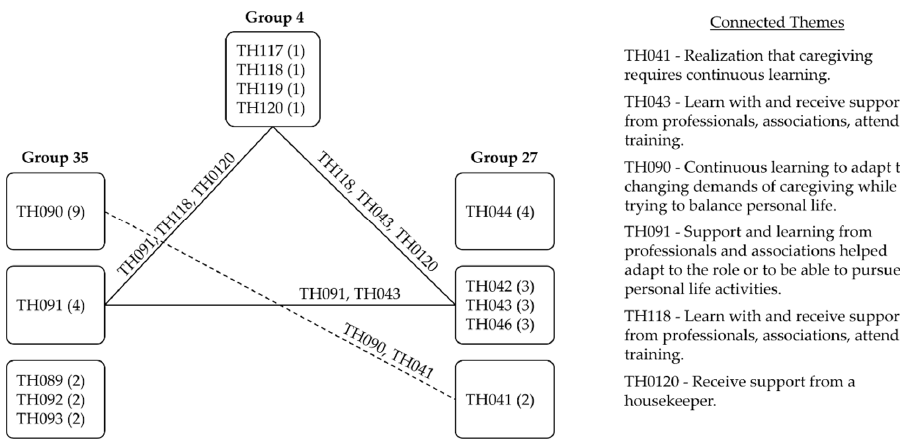
Figure 4. Network of themes in action.